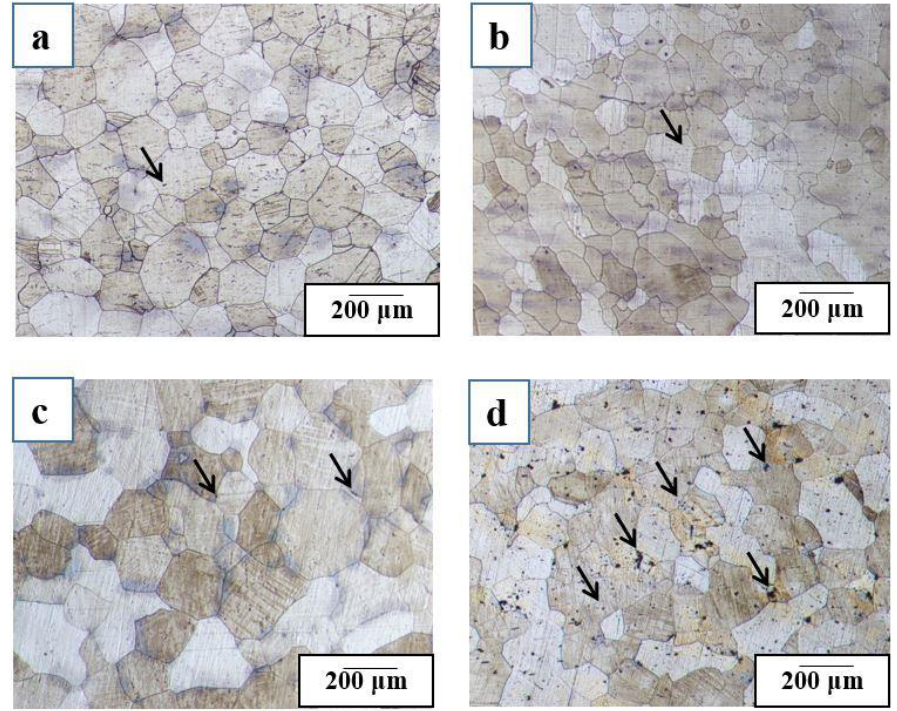
Figure 3. Optical micrographs of the of the peak aged treated: ( a ) Alloy-1; ( b ) Alloy-2; ( c ) Alloy-3; and ( d ) Alloy-4 specimens. The black arrows indicate precipitates with in the α -Al (matrix).